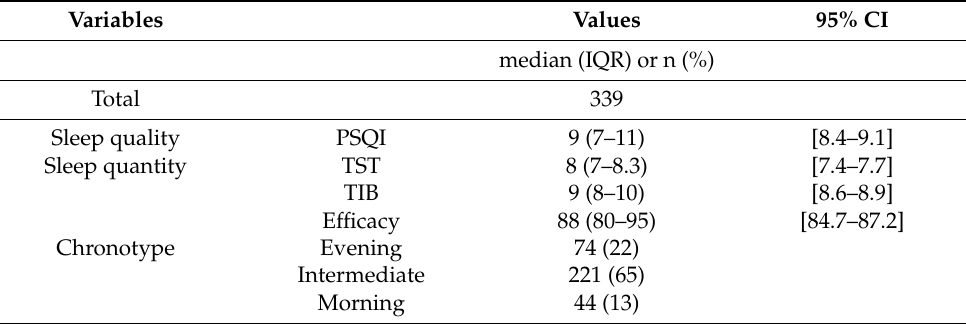
Table 2. Sleep characteristics of collegiate